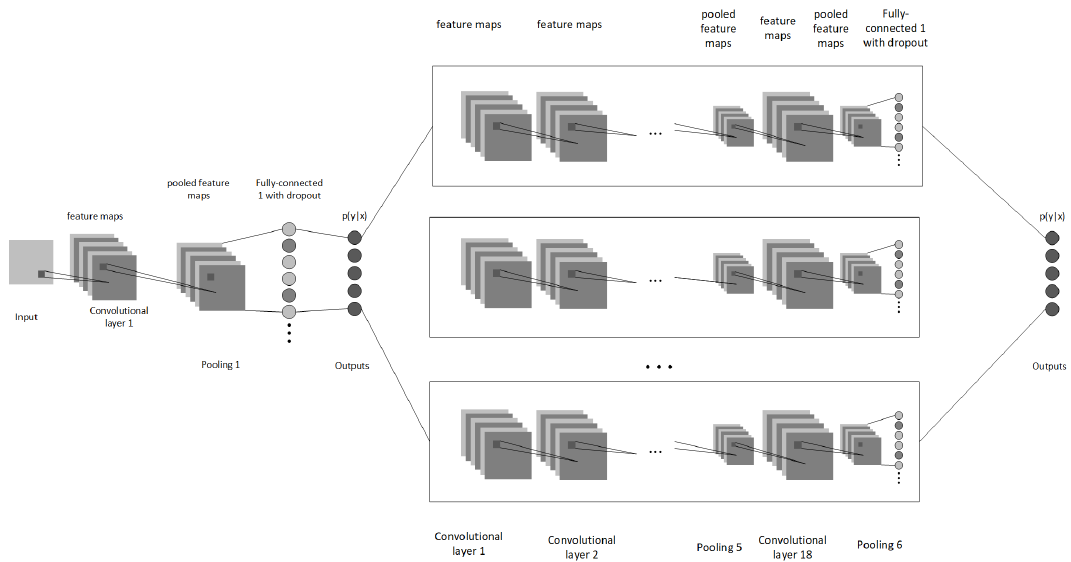
Figure 1. Architecture of hybrid neural network consisting of discriminator and reconstructor. The node accepts depth data as an input, applies a 3 × 3 max-pool convolution layer with a stride of 2 and 32 samples.